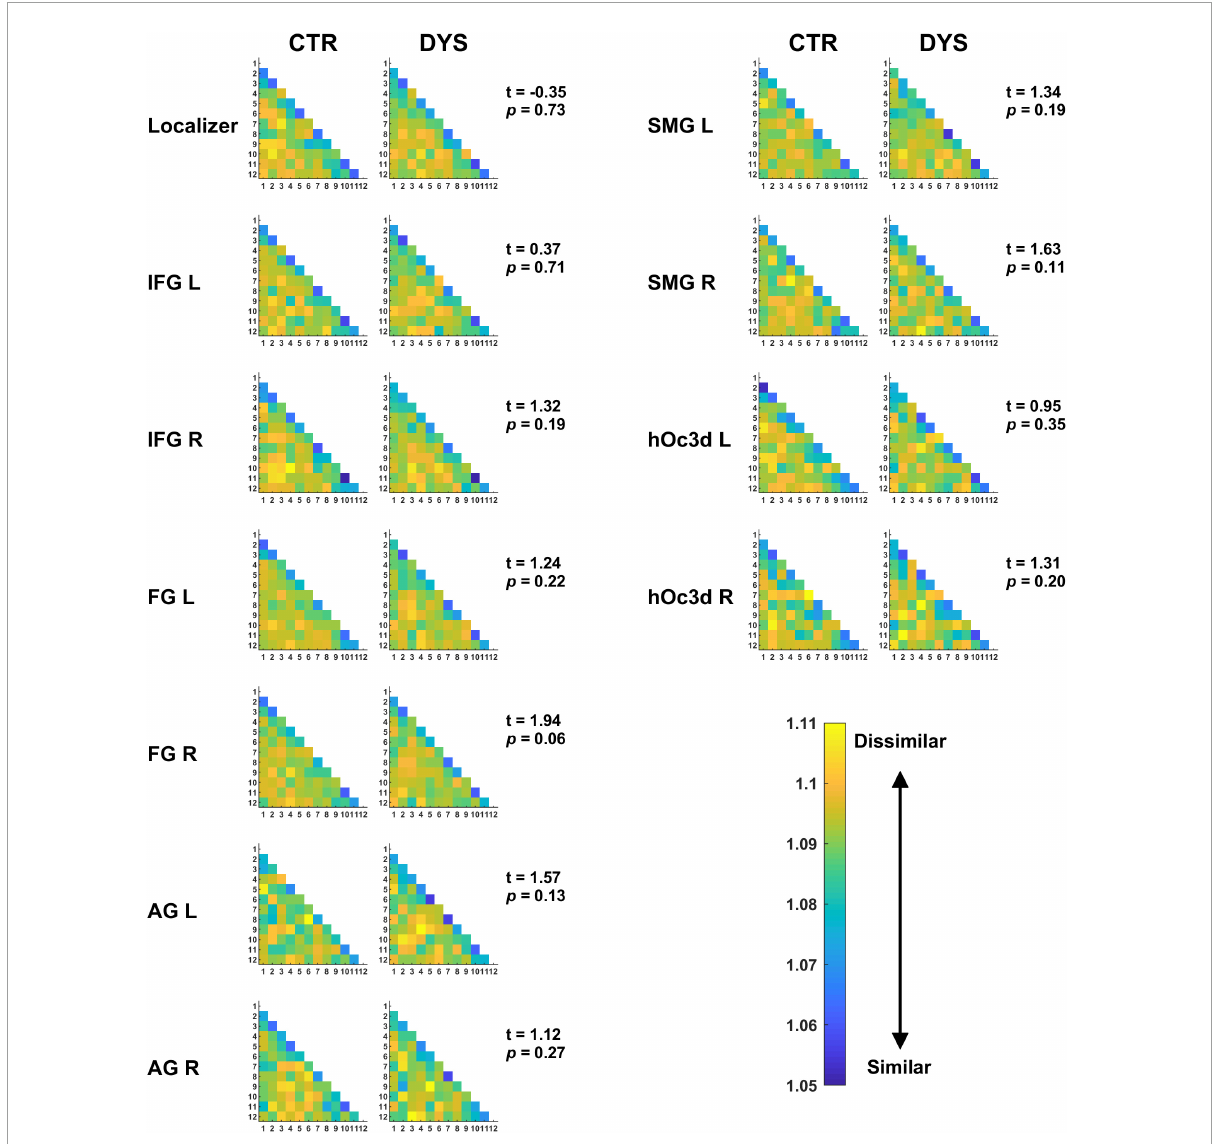
FIGURE9 The mean RDMs for repeated words in each ROI. The values in the matrix show the dissimilarity between each pair of repetitions (the higher the value, the lower the similarity). Potential group differences were assessed with a two-sample t -test (see t and p -values). DYS: dyslexic readers, CTR: typical readers, IFG: inferior frontal gyrus, FG: fusiform gyrus, AG: angular gyrus, SMG: supramarginal gyrus, hOc3d: dorsal extrastriate cortex, L: left hemisphere, R: right